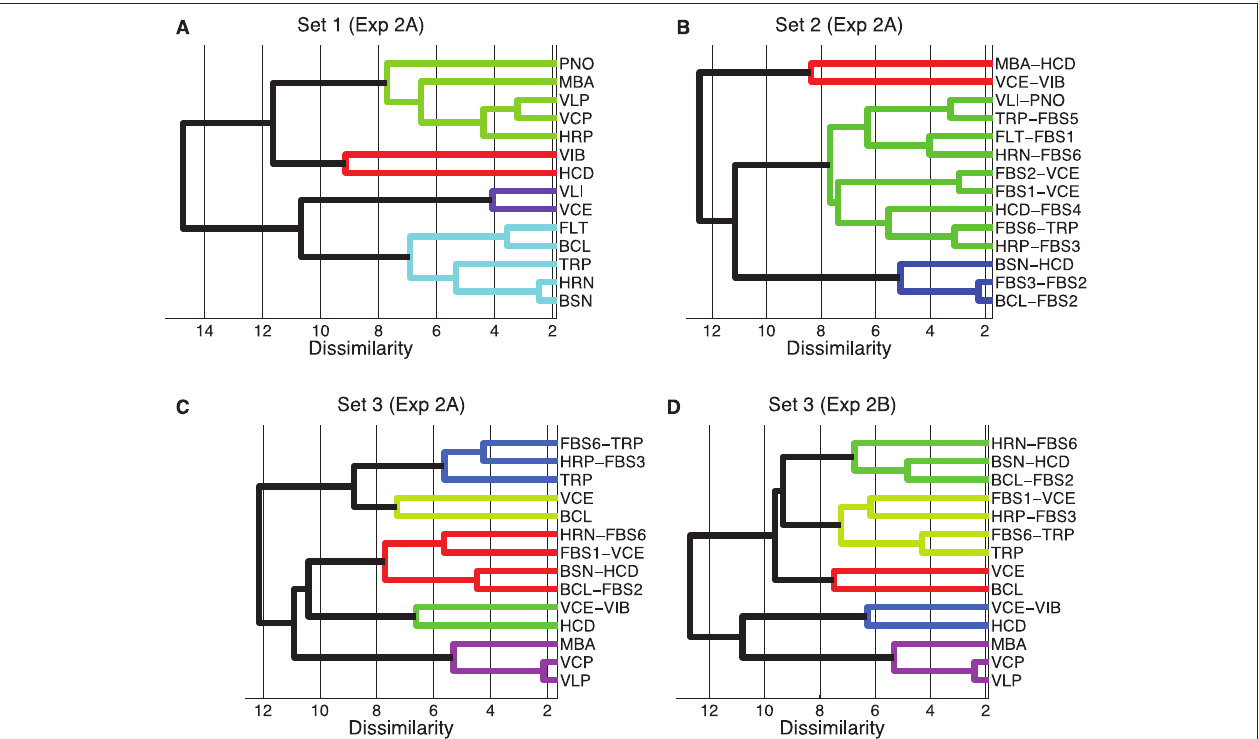
FIGURE 3 | Hierarchical clustering of mean dissimilarity ratings from Experiment 2A, Sets 1 (A), Set 2 (B), and Set 3 (C), as well as Experiment 2B, Set 3 (D), using the complete-linkage method. Color-coded groups are specified by a 70% linkage cutoff.